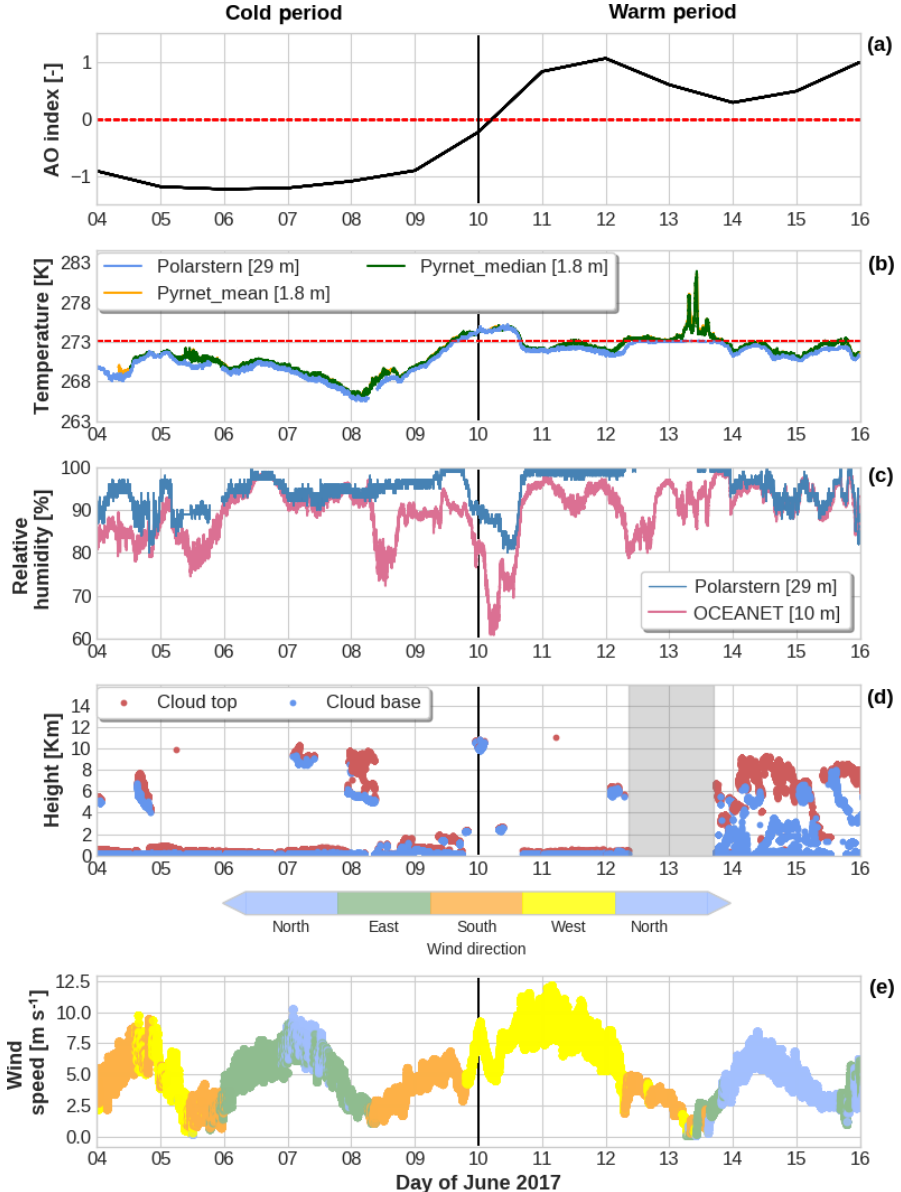
Figure 3. (a) AO index reported by the National Oceanic and Atmospheric Administration (NOAA). (b) Surface temperature from Polarstern meteorological instruments (blue), together with the mean (orange) and median (green) values from the pyranometer network. (c) Relative humidity (RH) from Polarstern (blue) and from the OCEANET container (pink). (d) Cloud base and cloud top height based on cloud radar and lidar. The gray background marks moments with no observations. (e) Wind speed (ms − 1 ) and direction obtained from Polarstern